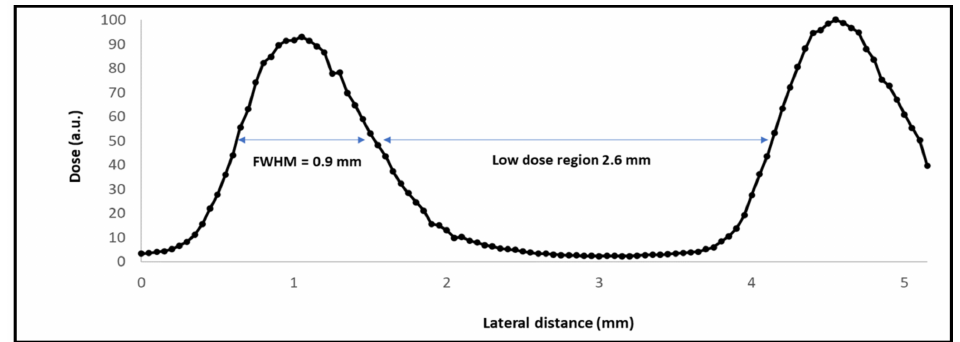
Figure 2. Central part of a minibeam radiation therapy (MBRT) dose profile measured at 5 mm depth in water by means of the microdiamond